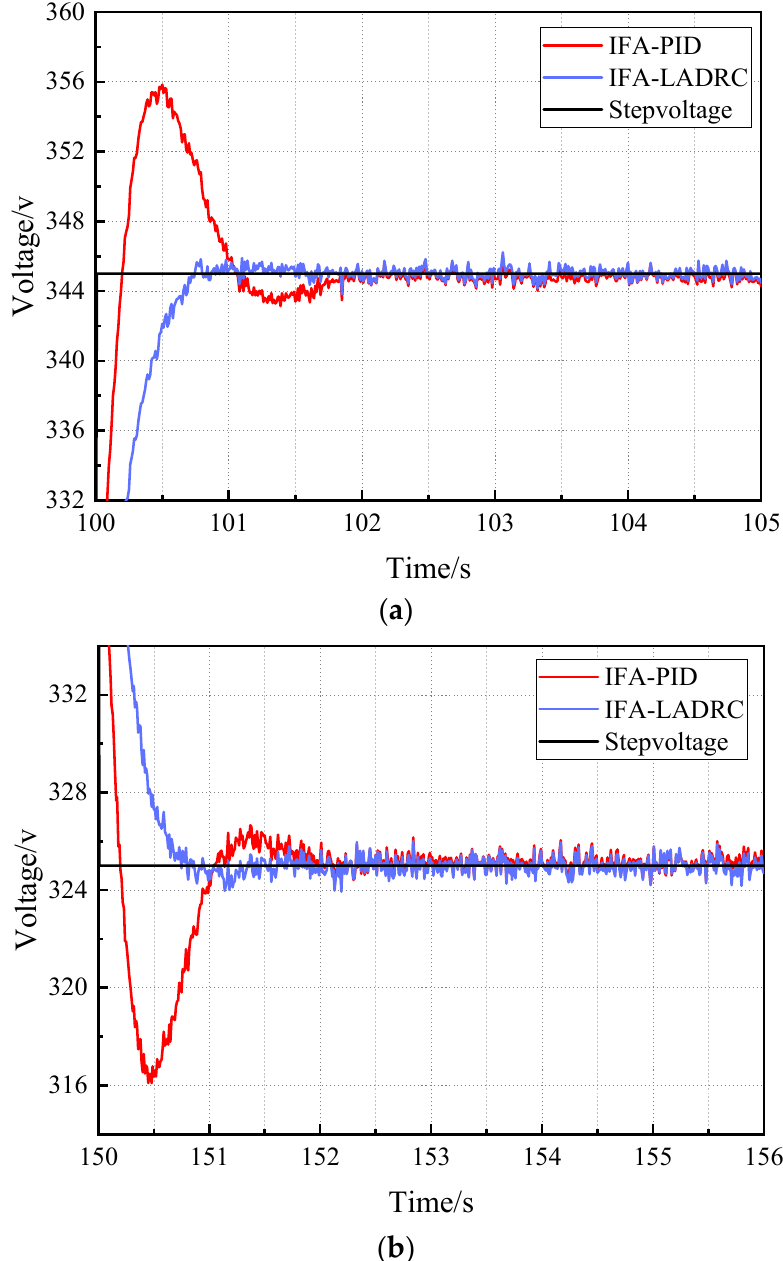
Figure 11. Voltage rise and fall response curves under different controllers. ( a ) Comparison of PID and LADRC boost voltage. ( b ) Comparison of PID and LADRC stepdown.